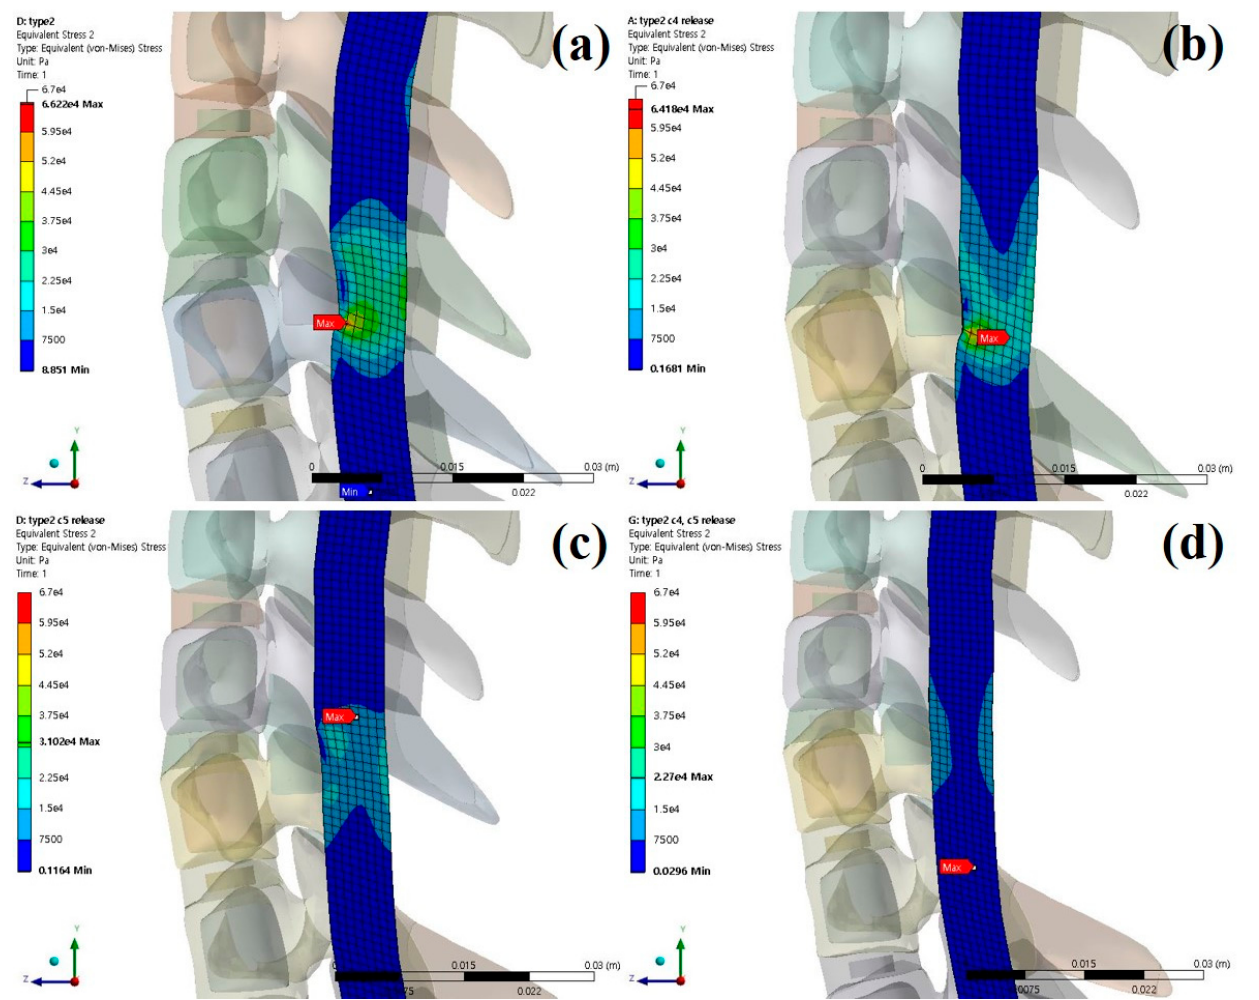
Figure 7. Neutral laminectomy simulation type 2 OPLL: ( a ) non-surgery model equivalent stresses (Pa); ( b ) C4 laminectomy model equivalent stresses (Pa); ( c ) C5 laminectomy model equivalent stresses (Pa); and ( d ) C4-C5 laminectomy model equivalent stresses (Pa).